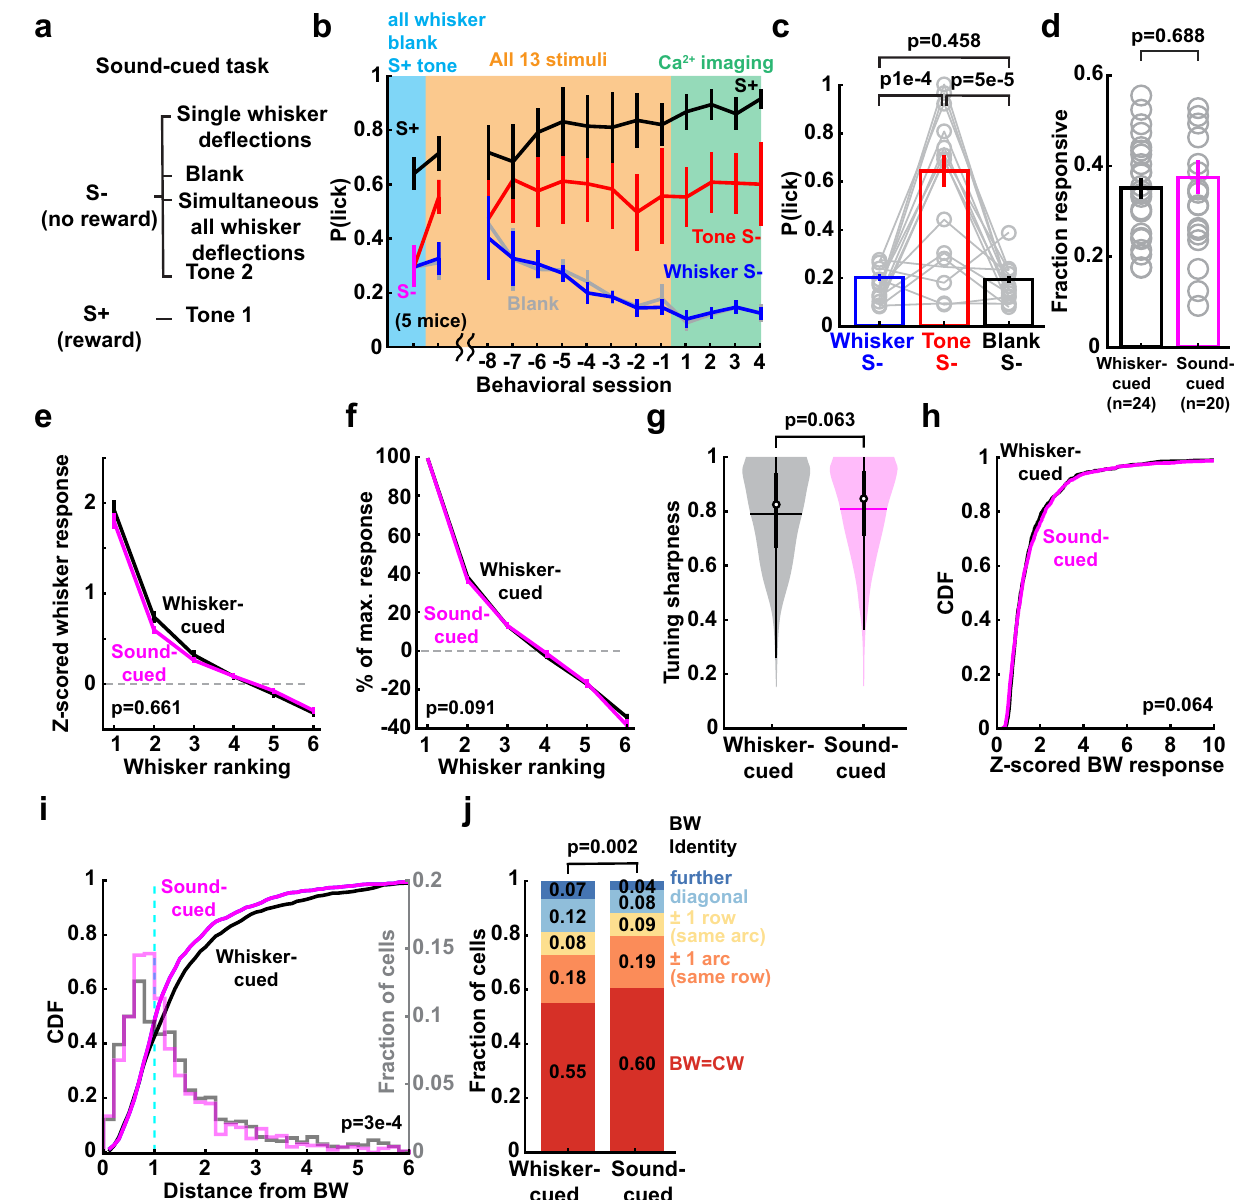
Fig. 4 | Whisker map differences between whisker-cued and sound-cued mice. a Stimulus-reward assignment for sound-cued task. b Behavioral performance during training on the sound-cued task, including after training on a partial sti- mulusset(blue),duringtrainingwithallS+andS − stimuli(yellow,showingthe fi rst sessionandthelast8sessionspriortoimaging),andoncemiceareexperts(green, showing the fi rst 4 imaging sessions). c Lick probability for each S − stimulus type during days − 3 to − 1 in ( b ). Each gray line is one session in one mouse. n =5 mice. Statistics: Friedman test, two-sided. d Fraction of whisker-responsive neurons in each imaging fi eld for one-versus-all (whisker-cued) mice and sound-cued mice. Each circle is one imaging fi eld. Statistics: rank-sum, two-sided. e , f Mean rank-